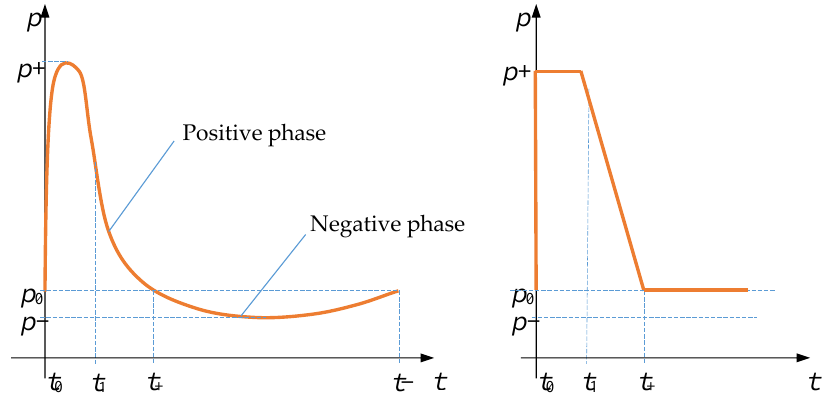
Figure 4. Pressure wave function and its simplification.